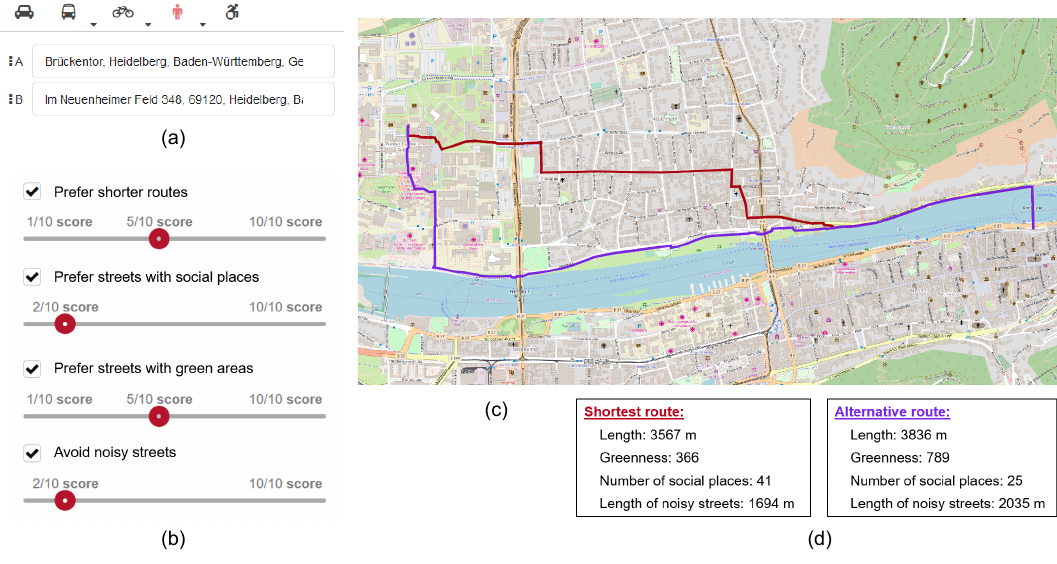
Figure 1. Main components of the proposed pedestrian routing system. ( a ) Origin and destination addresses are defined by the user. ( b ) Slide-bars to set the strength of influence of the different factors in the extraction of the customized route. ( c ) The system’s screen displays the shortest route (in red) and the customized route (in purple) over the OpenStreetMap layer. ( d ) A quantitative comparison between the shortest and customized routes in regard to the four factors is provided. The greenness variable is the street segment’s length multiplied by the relative area of the green areas inside its viewshed (see Section